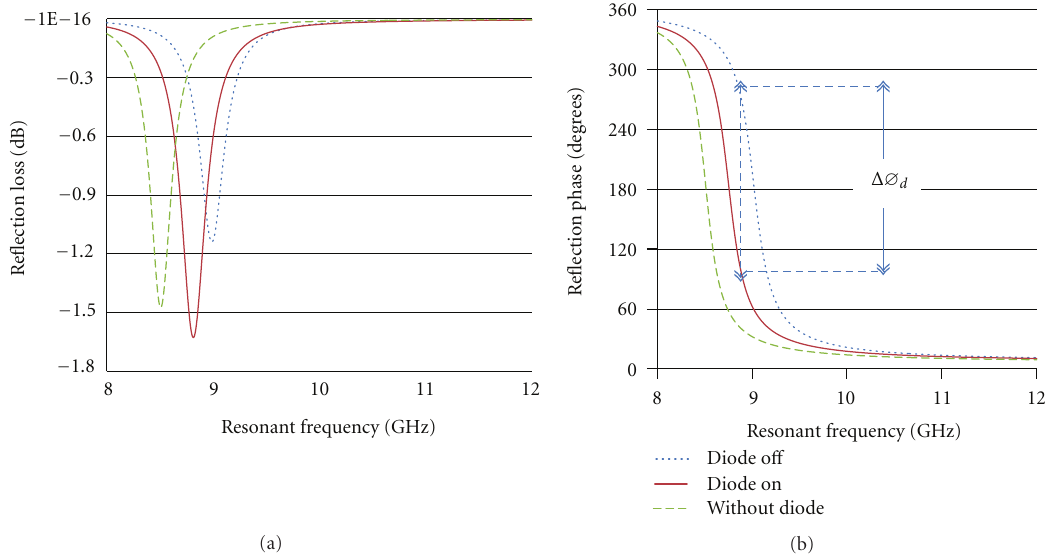
Figure 8: Reflection loss and reflection phase curves for tunable reflectarray design with PIN